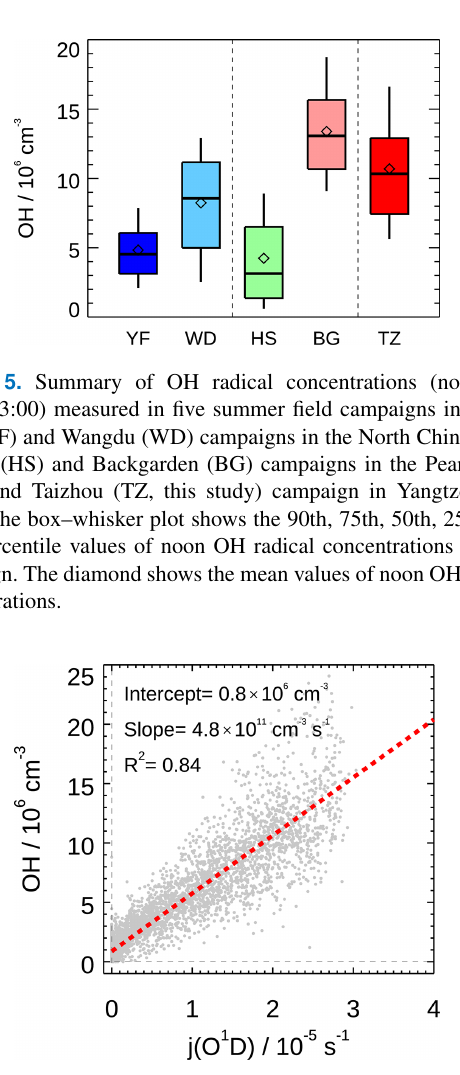
Figure 6. Correlation between measured OH and j (O 1 D). Grey scatter plot represents the 5min observation result for the EXPLORE-YRD campaign. A linear fit which takes both measure- ment errors into account is applied. The linear fit lines and correla- tion slopes, intercept, and coefficients are also